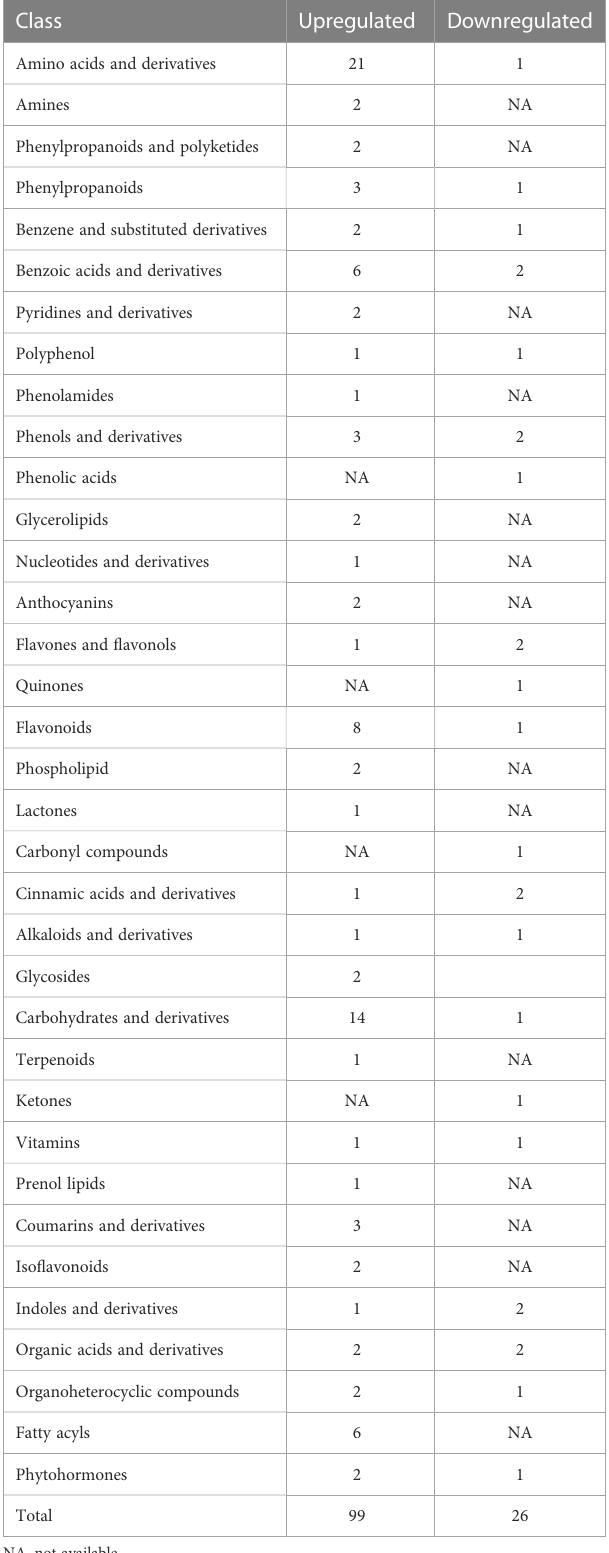
TABLE 2 The type and quantity of identi fi ed differential metabolites between CK and HT.